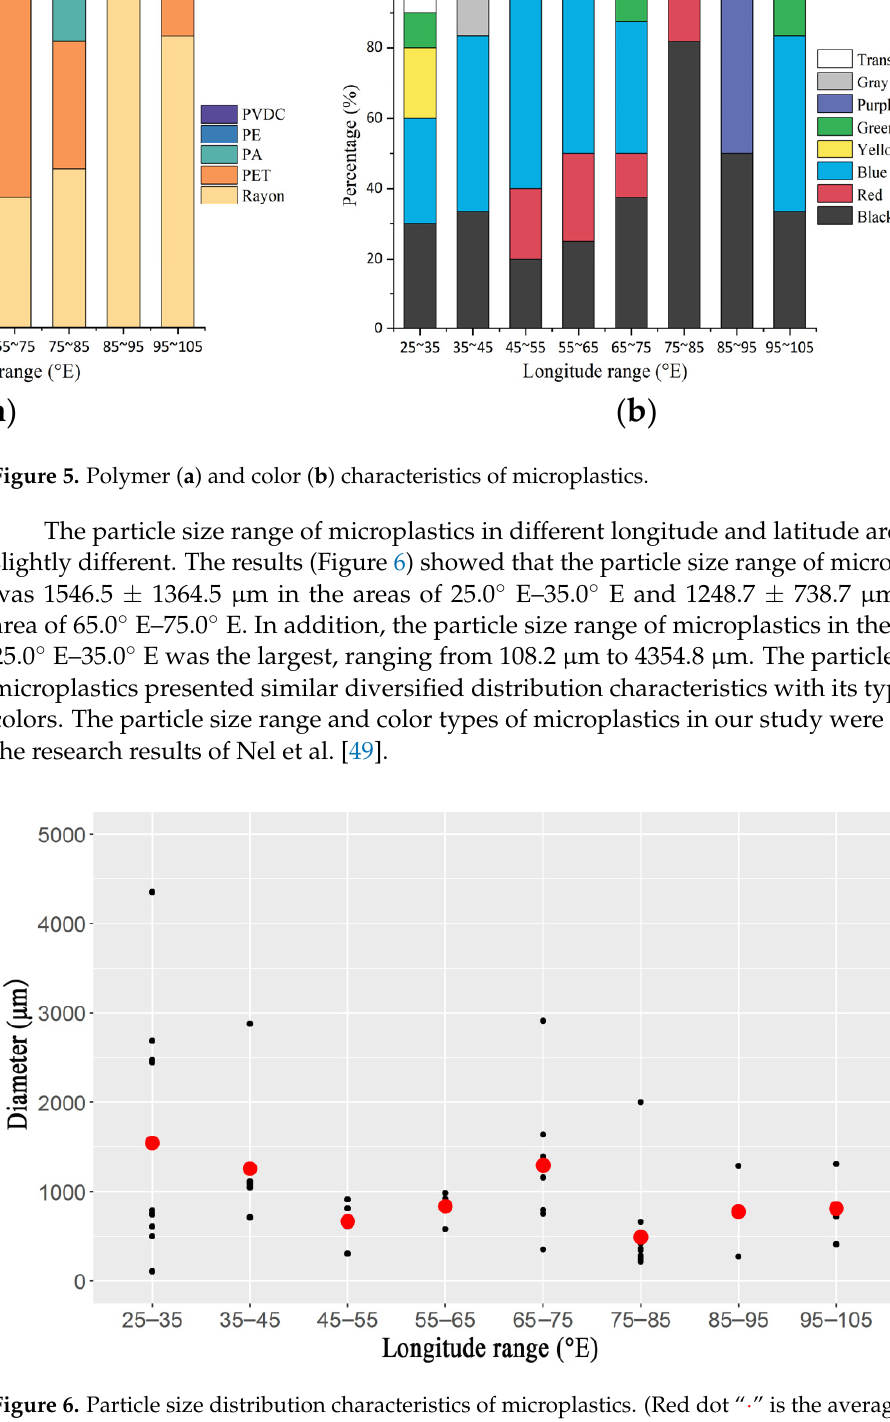
· ” is average particle size of